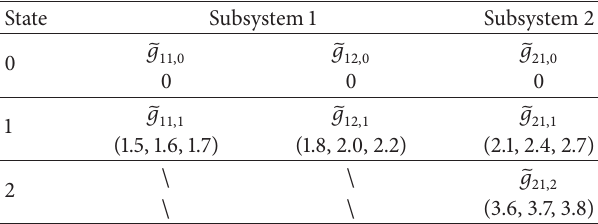
Table 2: The fuzzy performance rates for the components of each